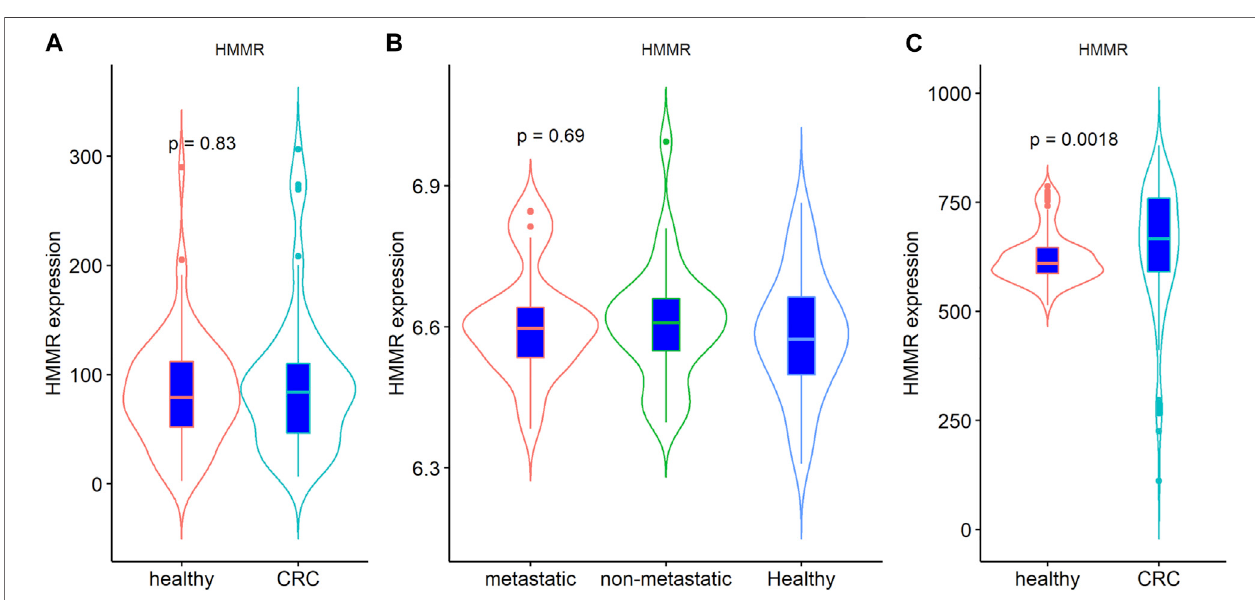
FIGURE 3 | Comparison of blood levels of HMMR in CRC and healthy controls: (A) results of GSE164191; (B) results of GSE47756, including patients with metastatic and non-metastatic cancer; (C) results of clinical blood samples.